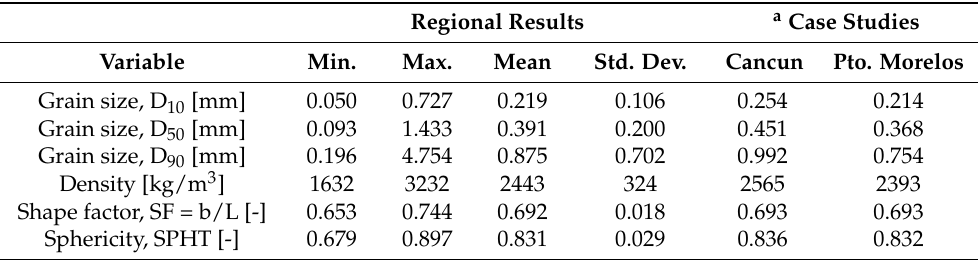
Table 1. Grain size (D 10 , D 50 and D 90 ), density, shape factor and sphericity for the sand samples from the study